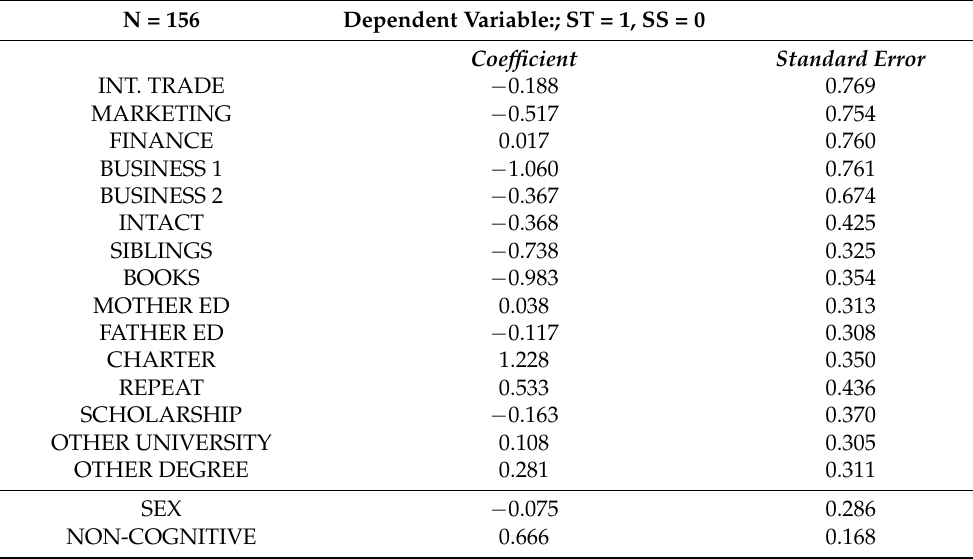
Table A3. Coefficients of a Probit model explaining the choice of Secondary Education